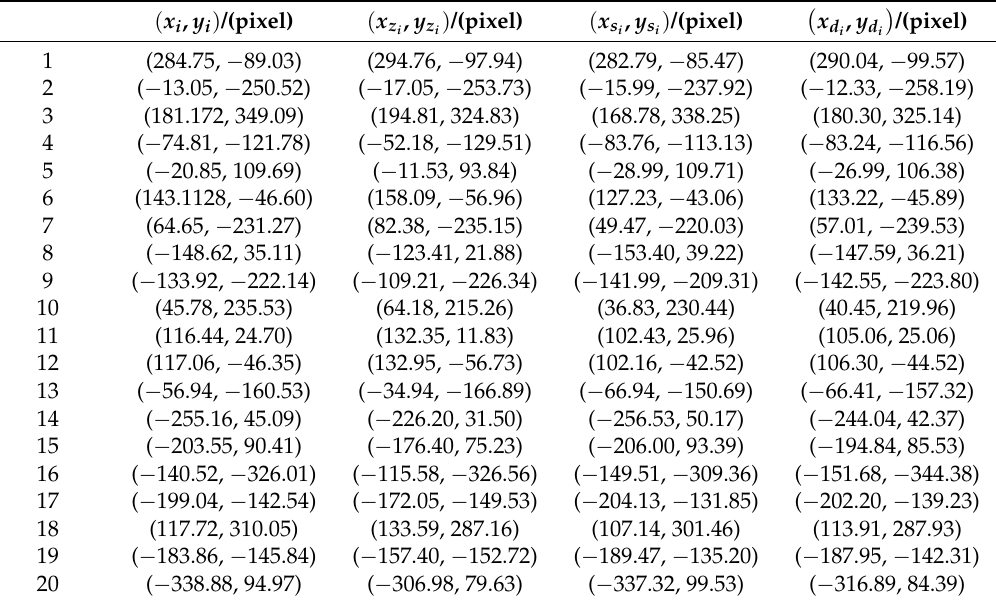
Figure 6. The measured values and theoretical values of the coordinates of star image points. Table 2. The coordinates of star image points.